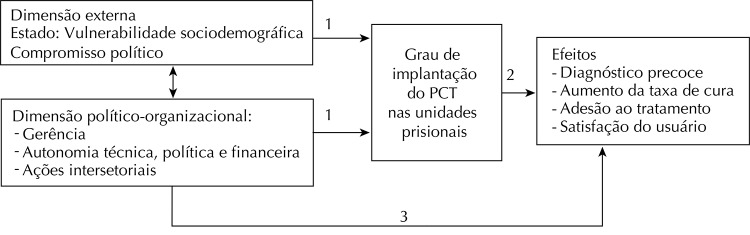
Modelo Teórico do Programa de Controle da Tuberculose (PCT) no sistema prisional. Brasil, 2012.